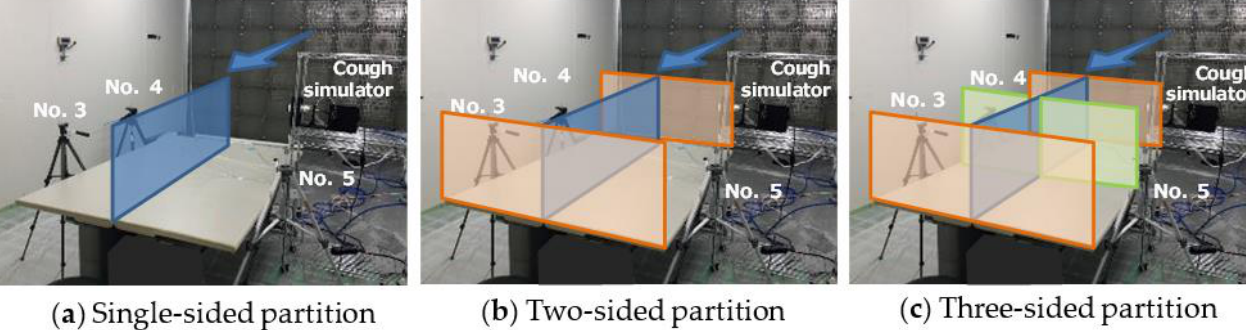
Figure 3. Partition installation conditions.